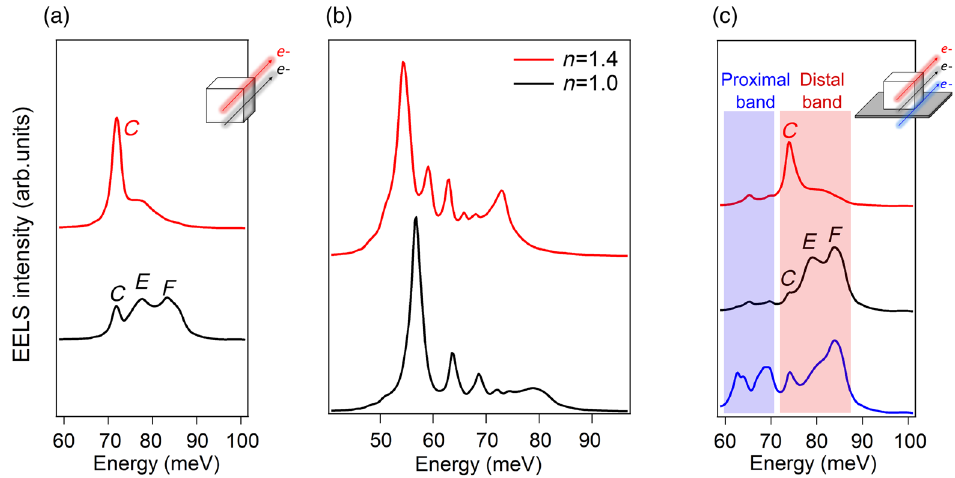
FIG. 4. Dielectric environment effect. (a) Simulated EELS spectra for a cube of MgO (100-nm edge long) in vacuum, exhibiting a corner ( C ), an edge ( E ), and a face ( F ) mode depending on the beam position. (b) Simulated EELS spectra for a nanorod ( 200 × 30 nm) in vacuum (black) and embedded into a dielectric of refractive index equal to 1.4. The beam is positioned at 10 nm from the tip of the nanorod in both cases. (c) Same simulations as in (a), but for a cube deposited on a substrate of refractive index n ¼ 2 . 3 . The former C , E , and F mode split into two bands. The distal band is essentially consisting in a series of C , E , F modes arising at almost the energy of the corresponding vacuum modes, while the proximal band is shifted towards the ω energy. Spectra corresponding to a given TO trajectory are indicated by their